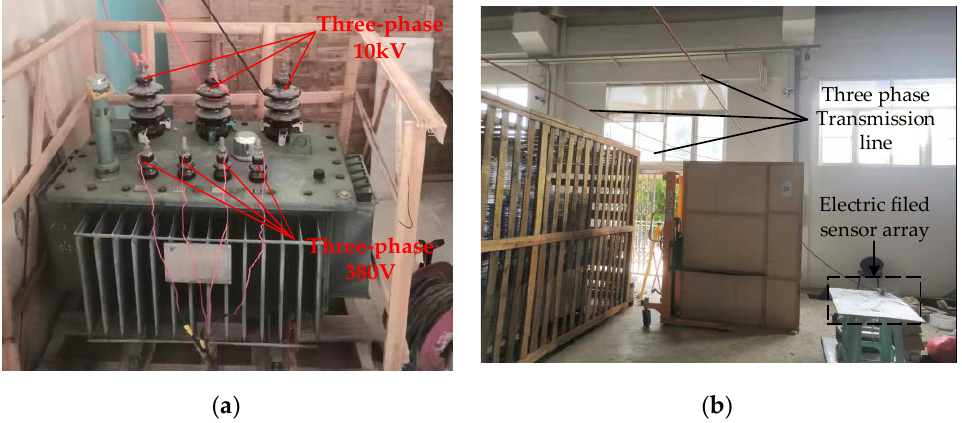
Figure 23. Physical diagram of the experimental platform.(a) 10kV transformer physical figure;(b) Experimental site figure